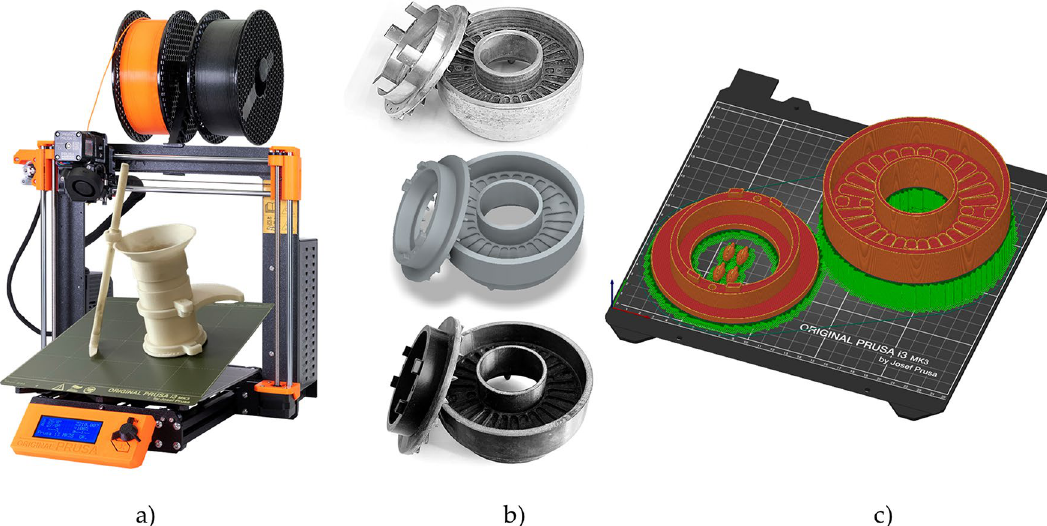
Figure 1. ( a ) Prusa i3 MKS3 printer with FT4’s 3D printed blade and vessel; ( b ) Schulze’s S size shear cell with lid (from top to bottom–aluminium, 3D CAD by Autodesk Inventor 2021, 3D printed); ( c ) Schulze’s shear cell sliced in PrusaSlicer version 2.3.0. This figure was created in Gimp